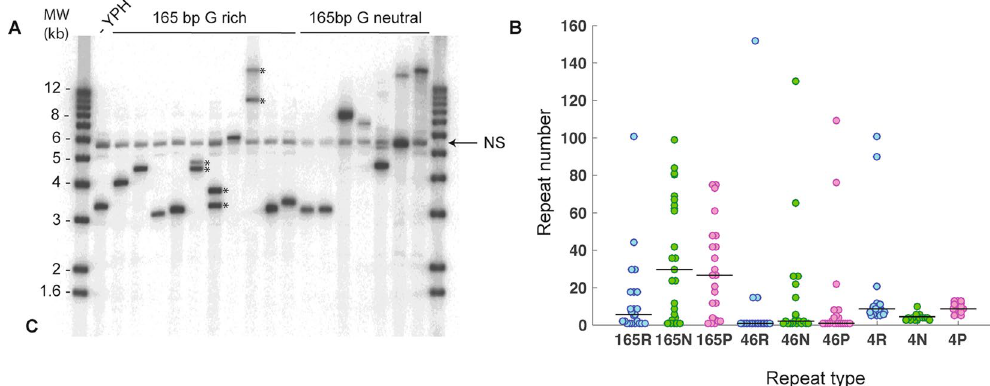
Figure 2. Analysis of tandem DNA repeats assembled at the YMR262 locus. (A) Southern blot analysis of genomic DNA from wild type YPH499 and edited strains containing DNA repeats of 165 bp G/C rich or G/C neutral repeats. Molecular weight (MW) is indicated in kb. In some clones, secondary rearrangements can be observed, leading to two repeated arrays of different sizes (indicated by * ). NS denotes on non specific hybridization present in all clones including with YPH DNA lane 1). (B) Beeswarm plots showing the size distribution of tandem repeats assessed by Southern blotting and Sanger sequencing for each type of repeat. The horizontal black line in each plots marks the median size of the arrays. Sequences of the analyzed clones are available in Supplementary Figs